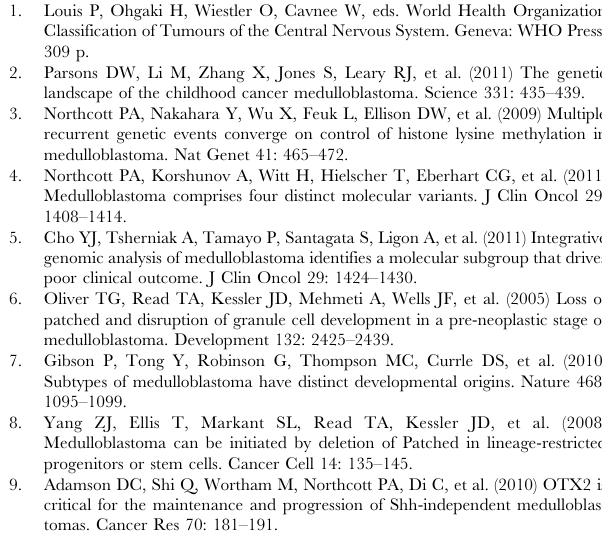
whole cerebella from adult wild type and GFAP:Hi-Otx2 mice. WT, wild type. UT, untreated. Asterisk indicates p # 0.05 relative to (C) untreated or (D) wild type. (PDF) Figure S2 Endogenous Otx2 expression is mostly restricted to GNPs and mature granule neurons. (A–E) Sections from P7 wild type mice were immunostained with the indicated antibodies, 20 6 magnification (mag) of posterior lobes are shown. egl, external granule layer. igl, internal granule layer. Arrows indicate overlapping expression of the indicated markers in individual cells. (PDF) Figure S3 Survival of GFAP:Hi-Otx2 mice. Animals were monitored from birth and sacrificed when moribund. p =0.11, Log-rank test. (PDF) Figure S4 Cerebellum and brainstem ectopia do not stain for lineage markers other than Math1/Pax6. Immunofluorescent images of ectopia from the cerebellum (A–F) and brainstem (G–L) of P7 GFAP:Hi-Otx2 mice stained with the indicated cell lineage markers or for Otx2 protein. 20 6 magnification (mag). (PDF) Figure S5 Otx2 does not induce Wnt pathway activation. Immunofluorescent staining (20 6 mag) for Ctnnb1 in ectopia of (A) the brainstem or (B) cerebellar white matter in GFAP:Hi-Otx2 mice. (C) Positive antibody control staining of mouse colon.